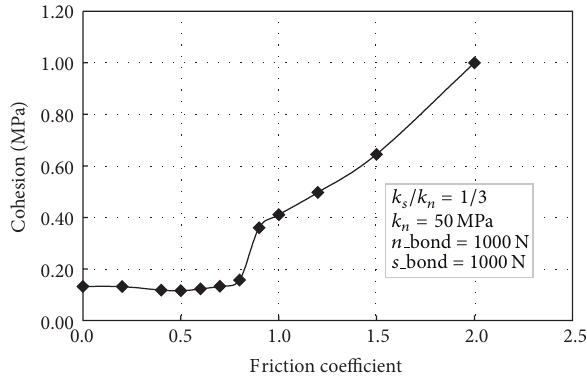
Figure 11: The cohesion remains constant if the coefficient of friction is low.